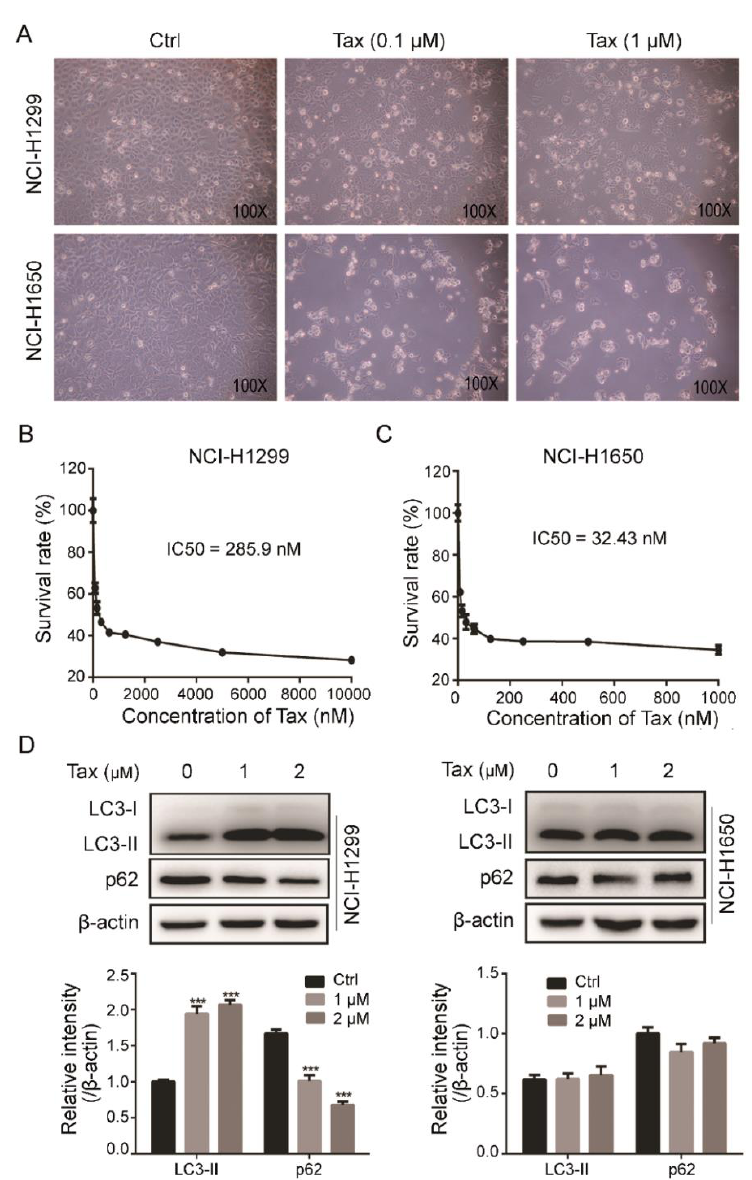
Figure 4. Paclitaxel (Tax) exerted different killing effects on different NSCLC cell lines, which was related to the degree of autophagy induction. ( A ) Cell morphology after 24-h treatment with 0.1 µ M or 1 µ M Tax. ( B , C ) Cell Counting Kit-8 (CCK-8) determination of viability of Tax-treated NCI-H1299 ( D ) and NCI-H1650 ( D ) cells. The median inhibitory concentration (IC50) was estimated by log(inhibitor) vs. normalized response nonlinear fit (GraphPad Prism 6.0). ( D ) Western blot evaluation of LC3 and p62 proteins in cells treated with Tax for 24 h. *** p < 0.001.